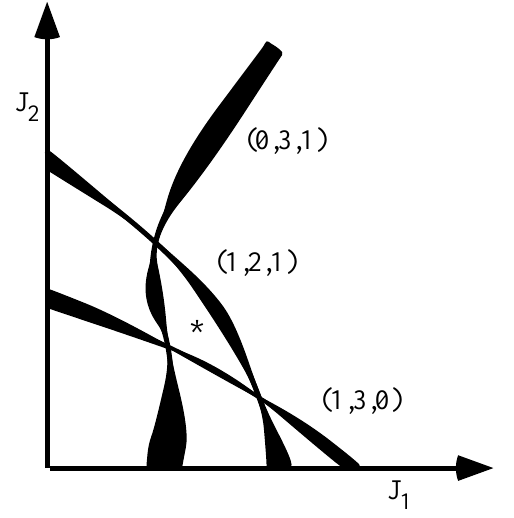
FIG. 3. Action plane showing resonance widths after obtaining A (cid:1) 4 and B (cid:1) 6 at the intersection of the resonance lines so that the resonance widths vanish